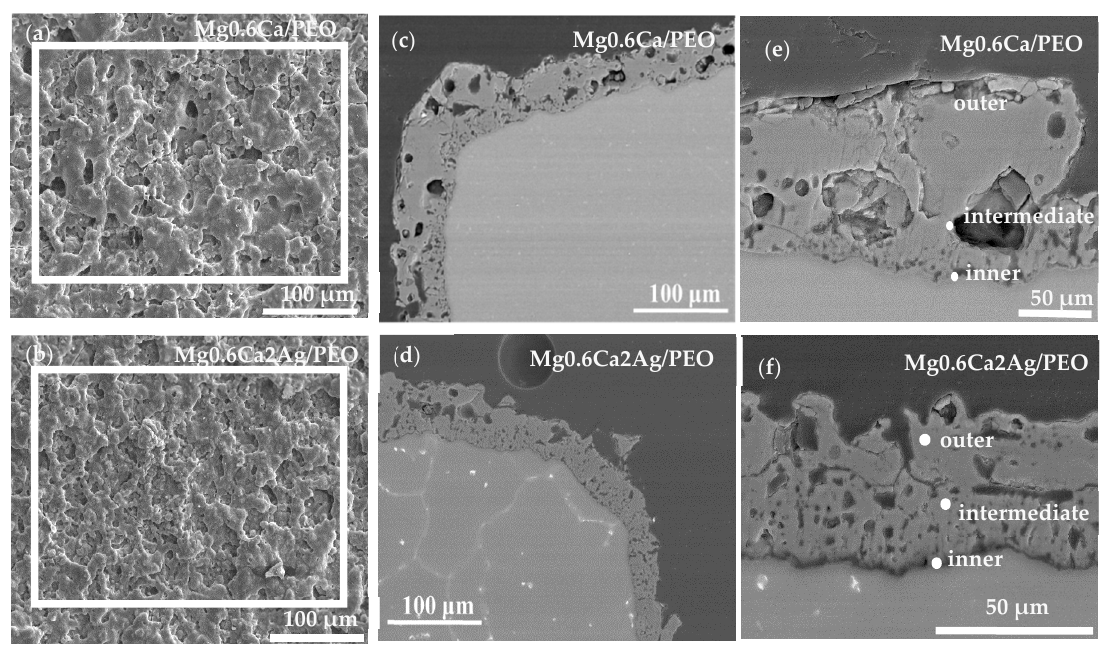
Figure 6. Backscattered electron micrographs of coating surface morphologies and cross-sections after corrosion of Mg0.6Ca/PEO ( a , c , e ) and PEO-Mg0.6Ca2Ag ( b , d , f ). Table 6. Compositions of Mg0.6Ca/PEO and Mg0.6Ca2Ag/PEO before corrosion by EDX (at.%).